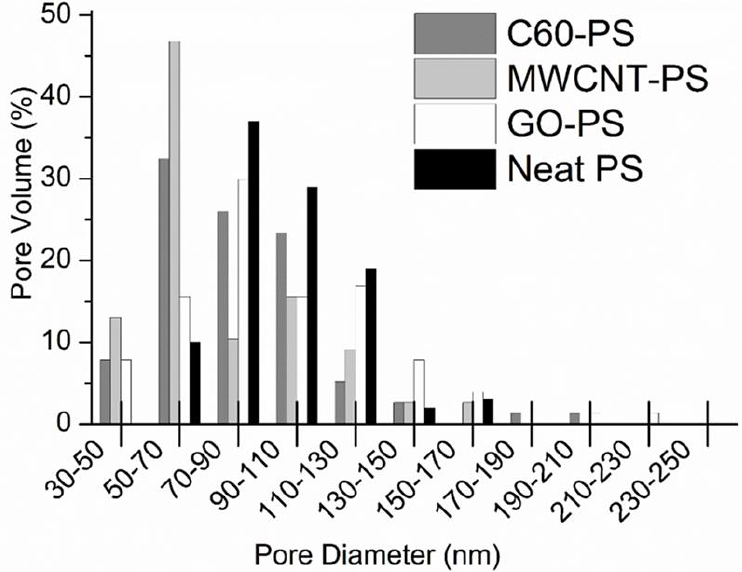
Figure 9. Distribution of the pore volume measured from scanning electron microscopy of nano- fibers [188]. PS, polystyrene; C 60 − PS, fullerene − polystyrene; MWCNT-PS, multi-walled carbon nanotube −polystyrene ; GO − PS, graphene oxide − polystyrene. Reproduced with permission from